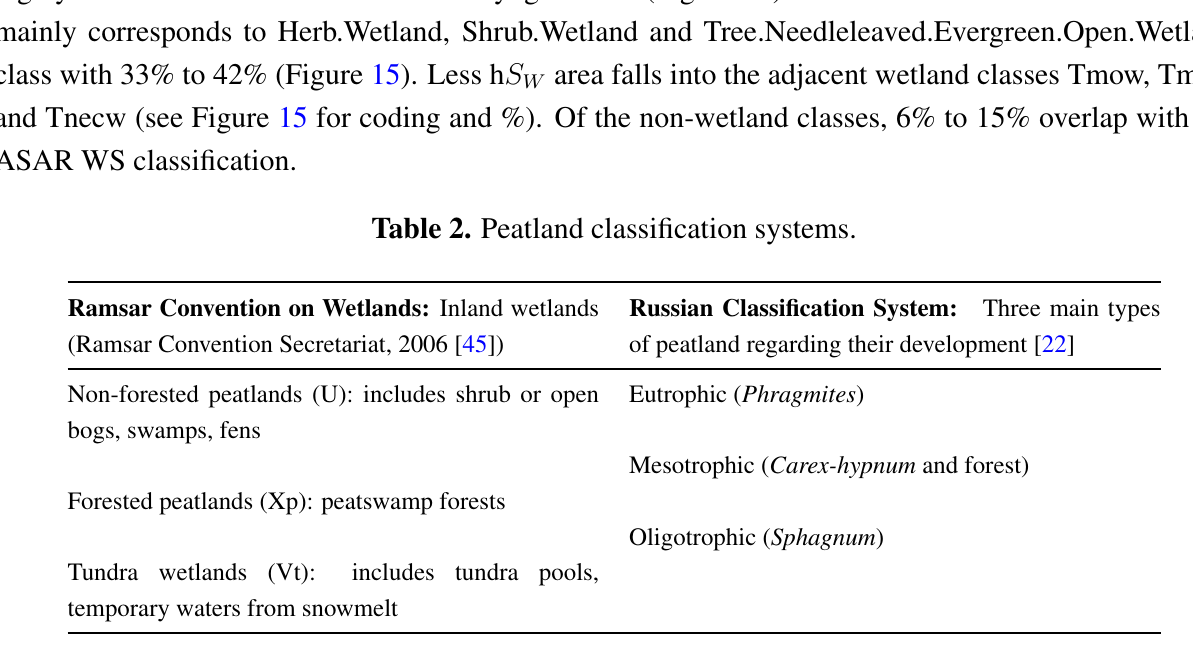
Figure 15. Percentage of h S area in different wetland classes derived from Vasyugan W mire classification in [39] (compare Figure 13: B = Bare, H = Herbaceous, S = Shrub, Tnec = Tree.Needleaved.Evergreen.Closed, W = Water, Tmc = Tree.Mixed.Closed, Tbdc = Tree.Broadleaved.Deciduous.Closed, Tmow = Tree.Mixed.Open.Wetland, Tmcw